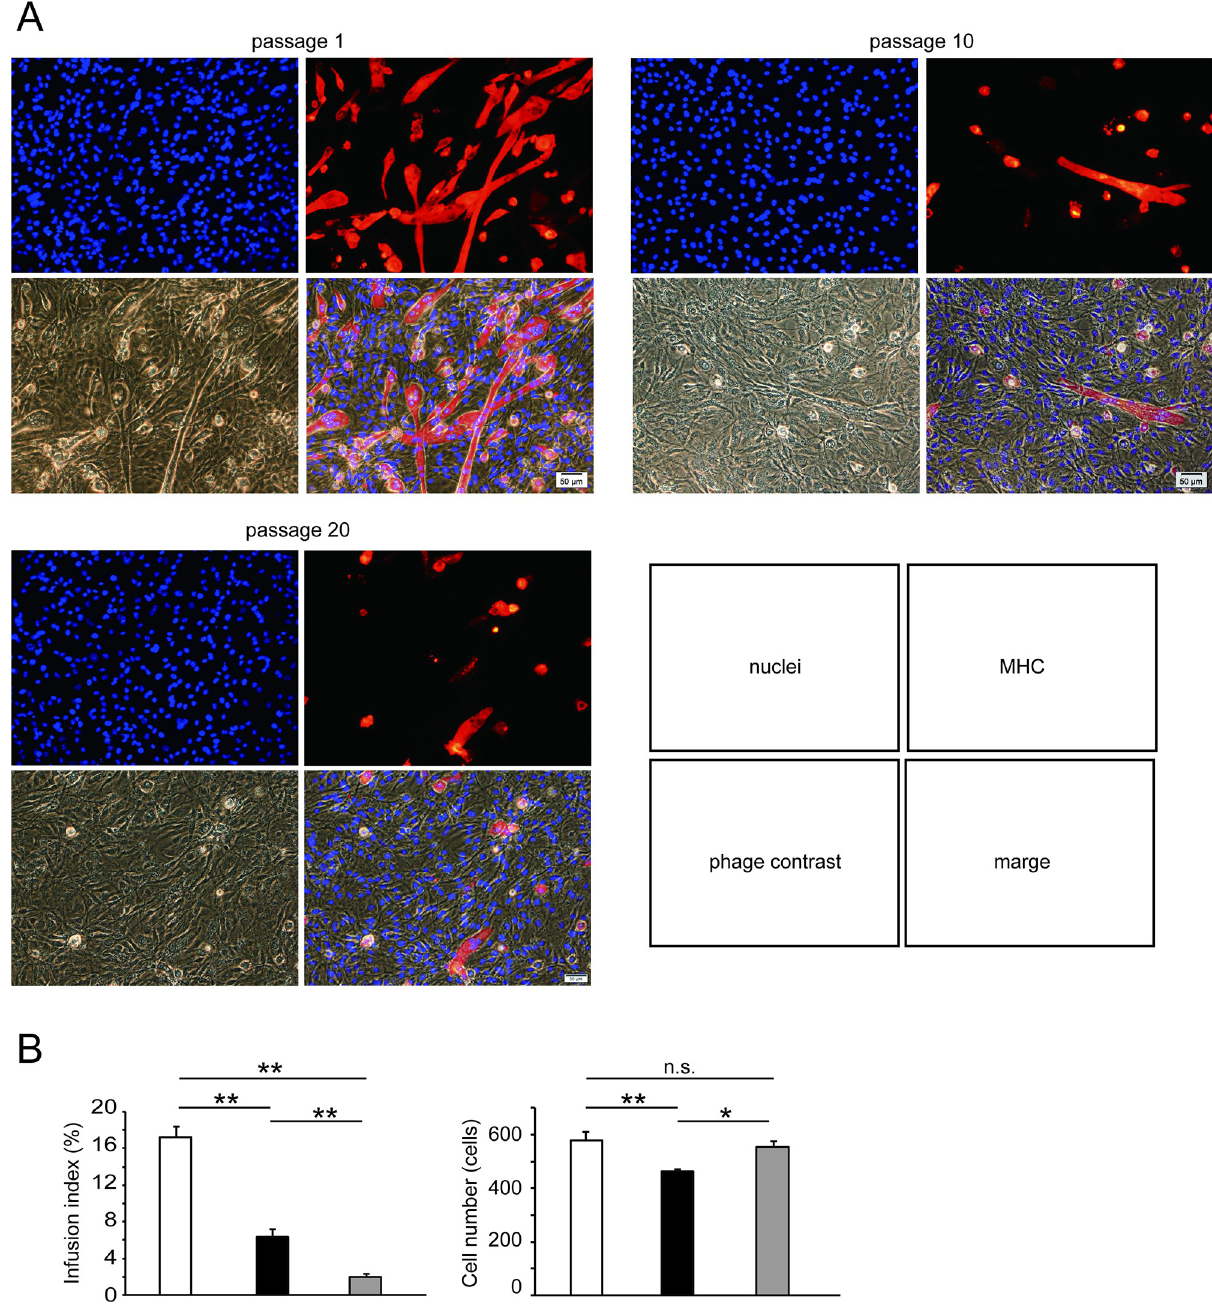
Fig 2. Effect of replicative senescence on myogenic differentiation of C2C12 cells. Panel A shows representative images of C2C12 cells after culture with differentiation medium for 7 days. Myogenic differentiation was induced in cells subjected to passage once (passage 1), 10 times (passage 10), or 20 times (passage 20). Red fluorescence of myosin heavy chain (MHC), blue fluorescence of nuclei, and phage contrast images were merged. Panel B shows the infusion index and the number of cells after myogenic differentiation for 7 days. Data are presented as means ± SE (n = 8 wells). � P < 0.05, �� P < 0.01; n.s., not significant (Tukey–Kramer